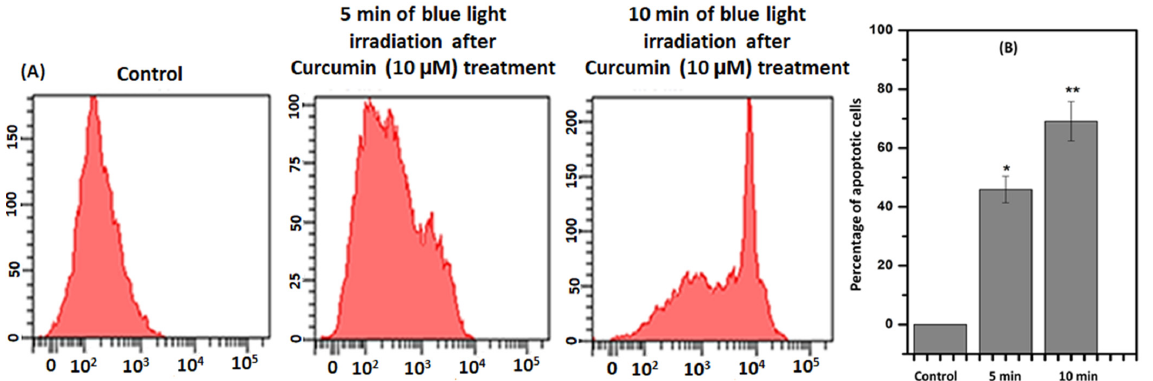
Figure 3. ( A ) Annexin V-FITC binding pattern of Curcumin (10 µM) treated and with the blue-light-irradiated cells at 5 and 10 min of the time interval. ( B ) The quantitative and statistical analyses of apoptotic cell death after 5 and 10 min of blue-light-irradiated to Curcumin-treated (10 µM) cells where: * denoted control versus 5 min of irradiation after Curcumin treatment (10 µM), and ** denoted control versus 20 µ M. The significant results presented a p -value <